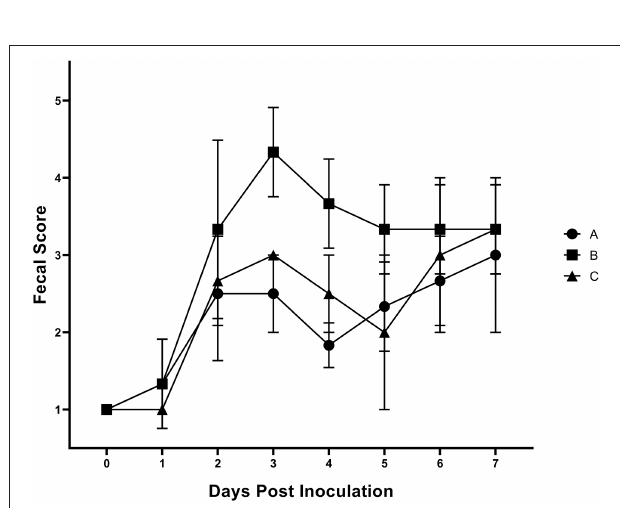
FIGURE 2 | Mean fecal scores from animal study #1 following inoculation on DPI 0 with three separate isolates of S. 4,[5],12:i:- (A, B, C). The fecal scoring system ranged from 1 to 5, with 1–2 being considered normal and 5 being considered severe diarrhea. The mean and standard error are represented by the vertical